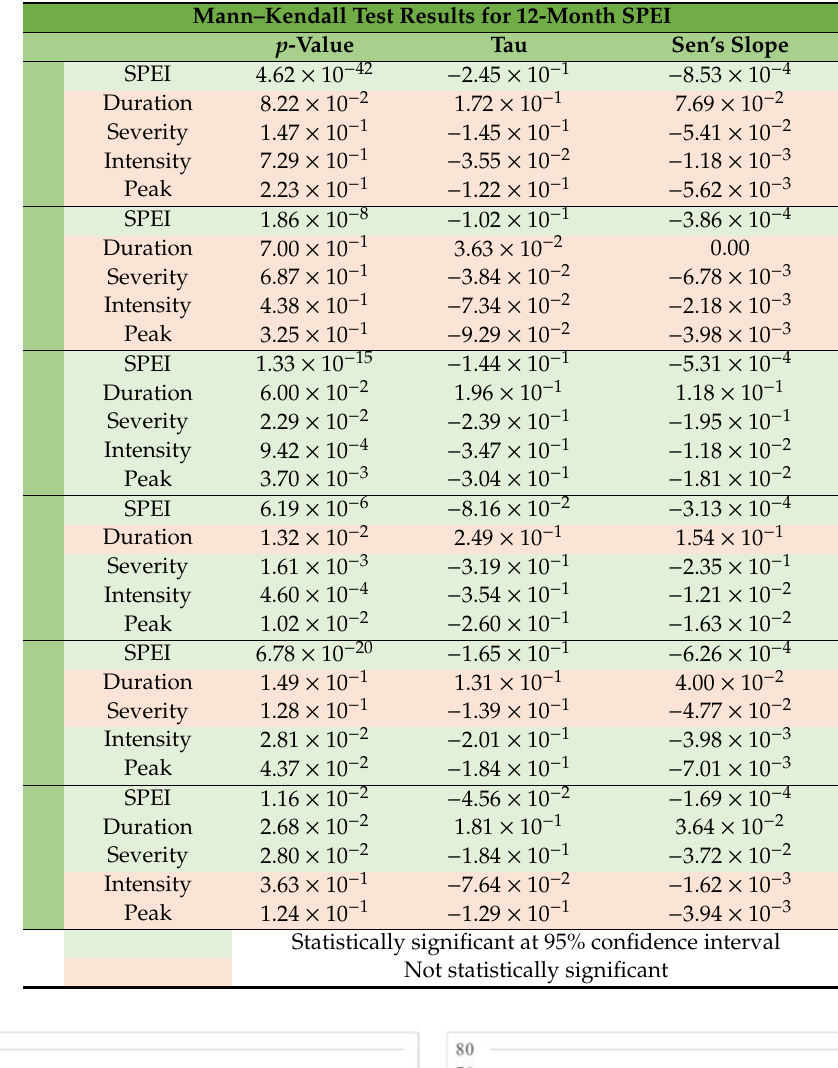
Table 2. Mann–Kendall test results for 12-month SPEI. Mann–Kendall Test Results for 12-Month SPEI